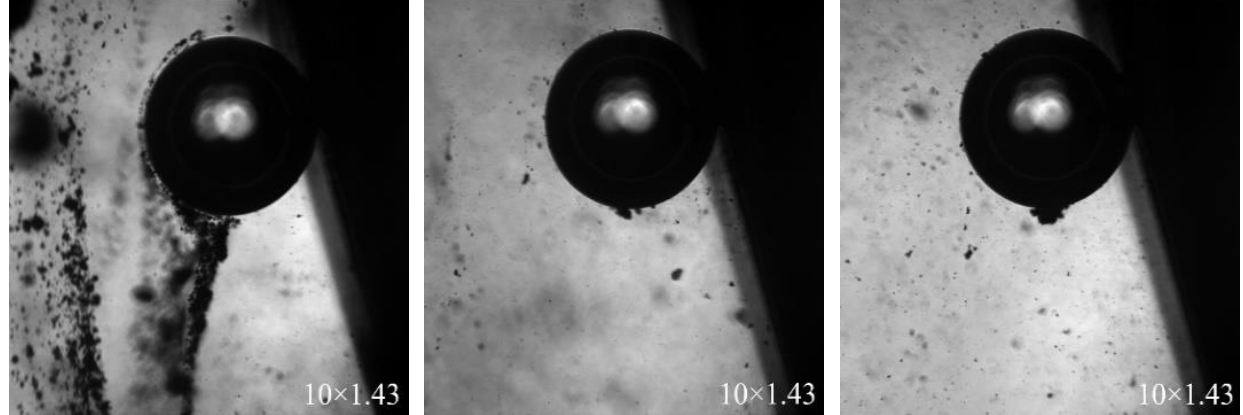
Figure 10. Contact between mineral particles and bubbles.